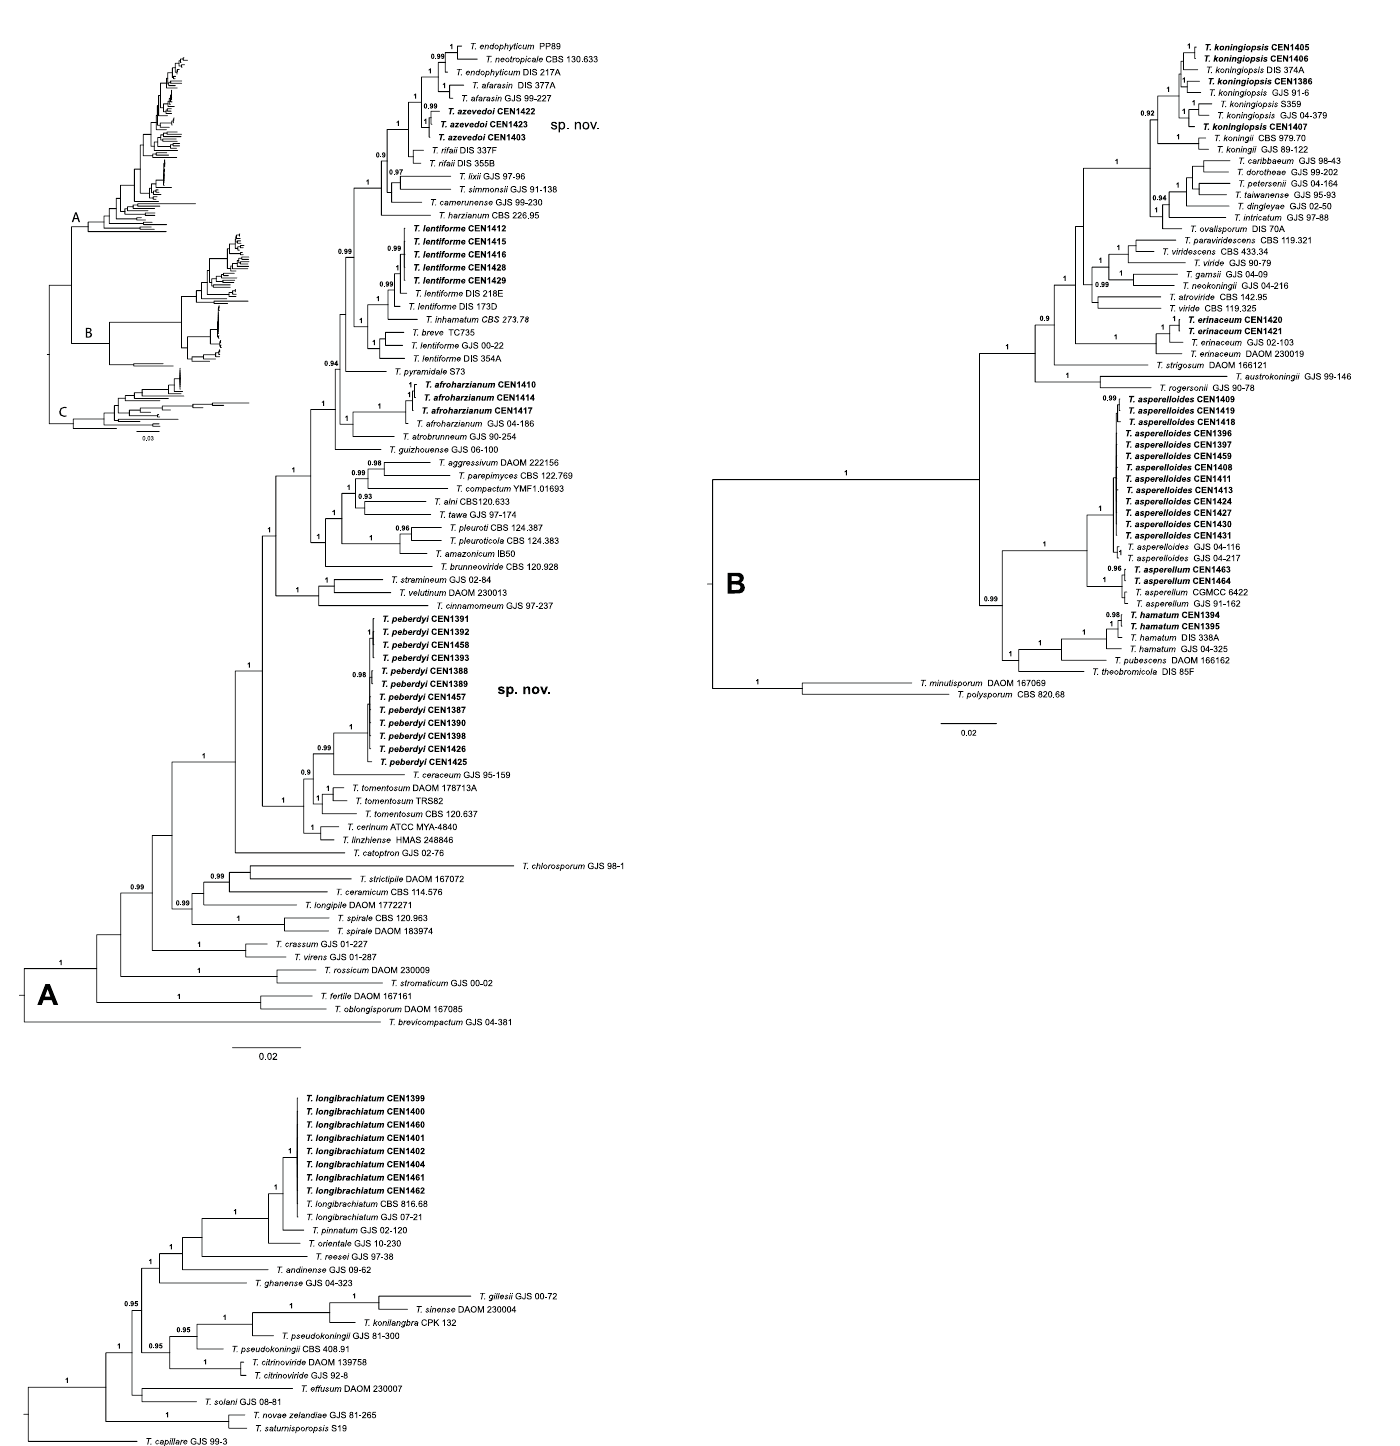
PLOS ONE | https://doi.org/10.1371/journal.pone.0228485 March 4,